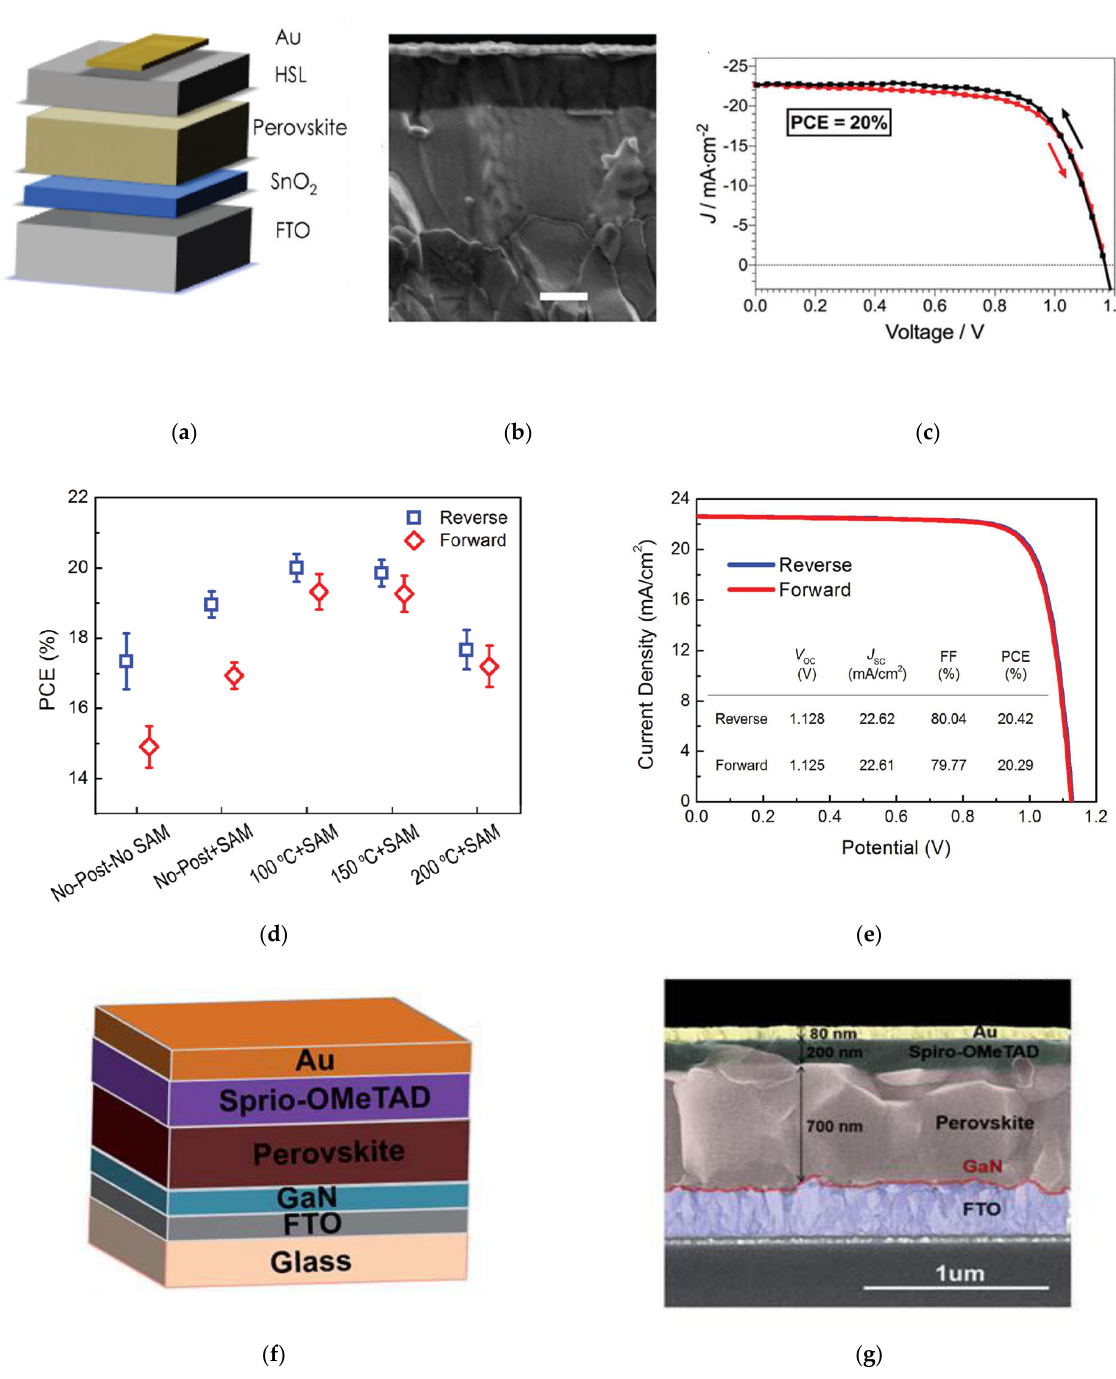
Figure 2. Incorporation of atomic layer deposition (ALD) processes for SnO 2 as electron transport layer (ETL): ( a ) Schematic of device configuration; ( b ) Cross-sectional scanning electron microscopy (SEM) image of the planar SnO 2 -based PSC (scale bar is 200 nm); ( c ) Illuminated current density vs. voltage scans for PSC with 15 nm of ALD SnO 2 . Reproduced from [24], with permission from the Royal Society of Chemistry, 2017. Incorporation of ALD processes for SnO 2 as ETL in PSC with self-assembly monolayer (SAM) treatments: (d) Comparison of power conversion efficiency (PCE) between reverse and forward voltage scan for varying post-annealing and SAM treatments; ( e ) Illuminated current density vs. voltage (J–V) of optimal device. Reproducedfrom [25], with permission from Wiley, 2017. Incorporation of ALD processes for GaN as ETL in PSC: ( f ) Solar cell device configuration; ( g ) Cross-sectional SEM image of device. Reproduced from [30], with permission from the Royal Society of Chemistry, 2019.